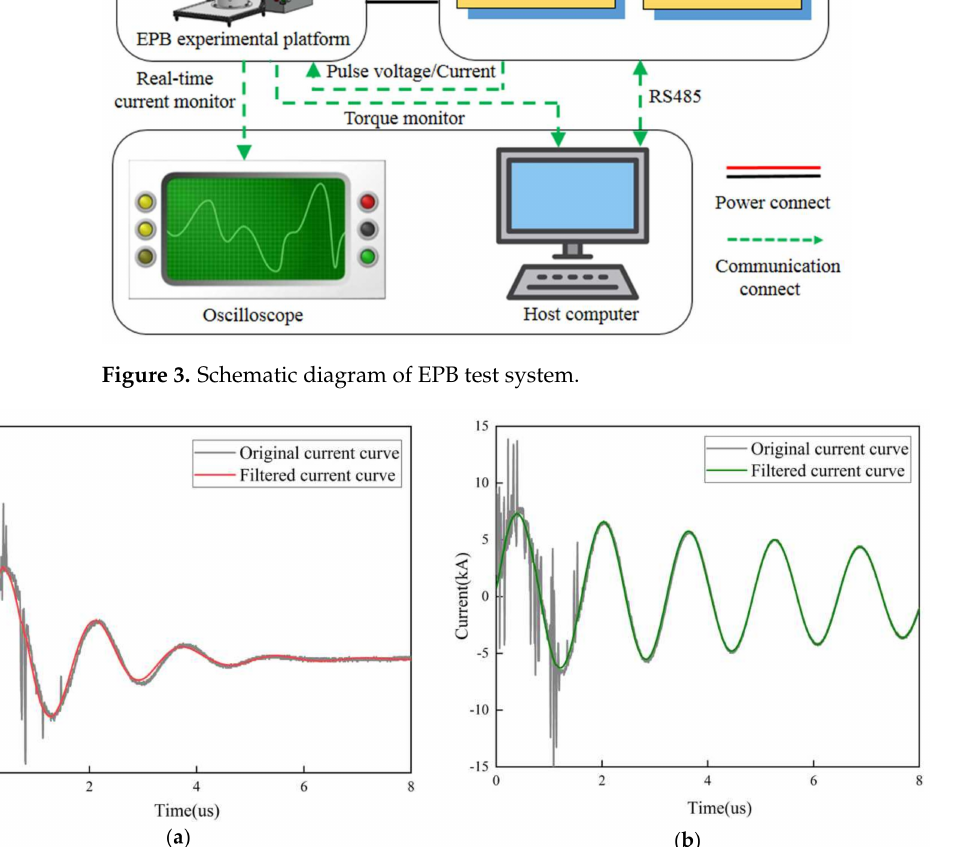
Figure 4. Original signals and filtered curves: ( a ) red sandstone and ( b )